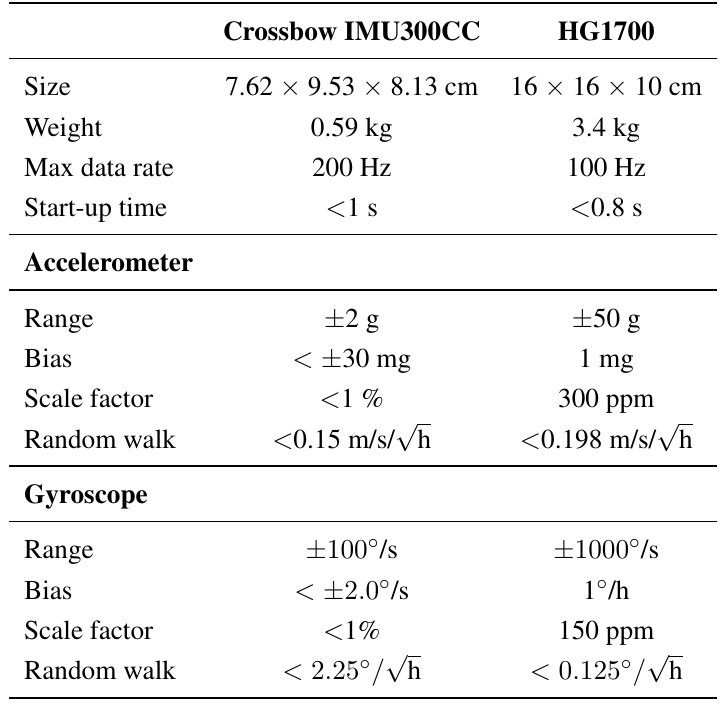
Figure 5. Navigation equipment and supporting hardware placed in a van for trajectory data collection. Table 1. Characteristics of the Crossbow and Honeywell